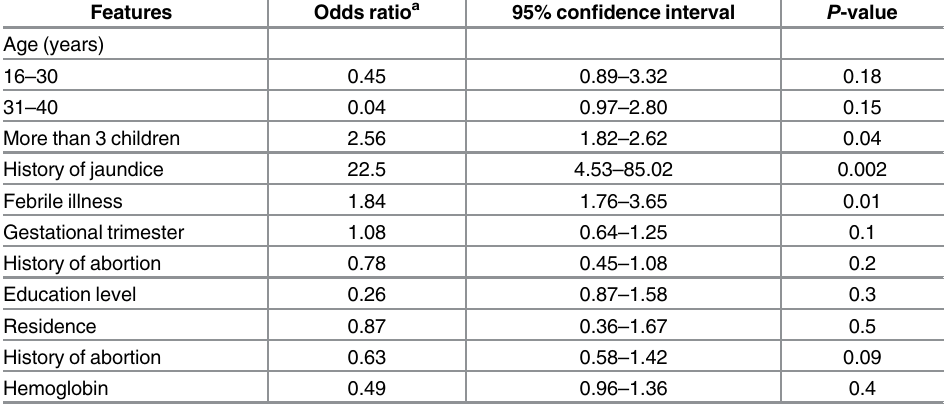
Table 2. Logistic regression analysis of demographic and clinical features of mothers infected with active CMV infection.